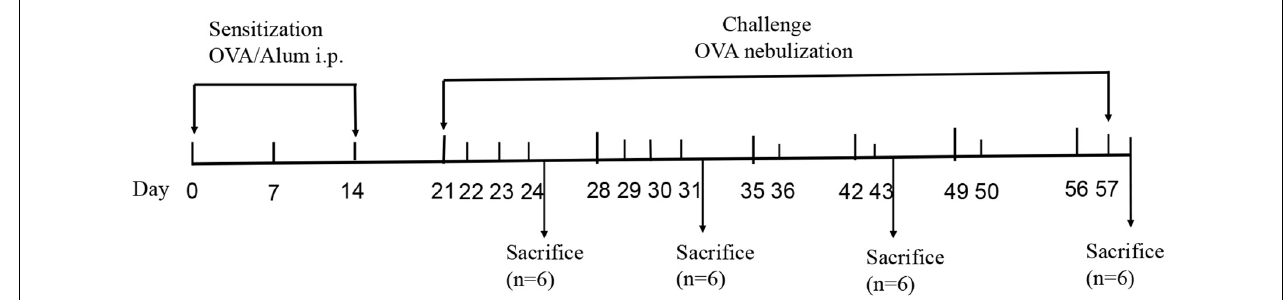
FIGURE 1 | Sensitization-challenge protocols for mice with OVA-induced